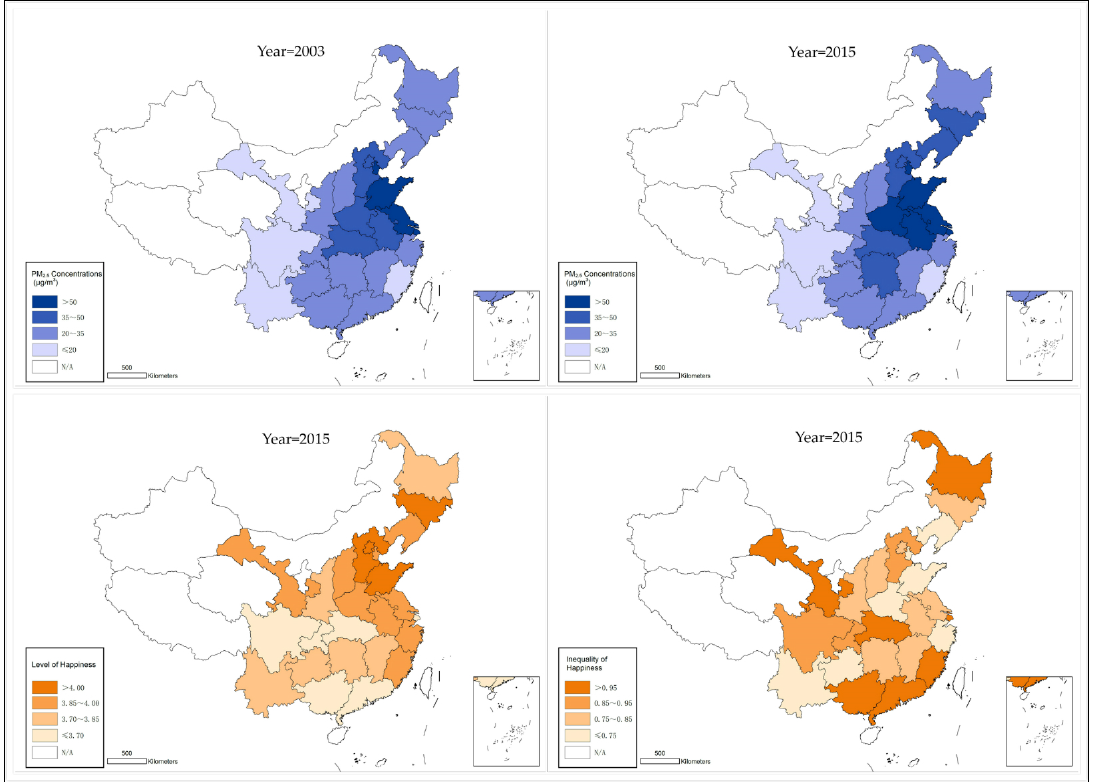
Figure 1. Spatial distribution of PM 2.5 concentrations, the level of happiness, and inequality of happiness in selected years.